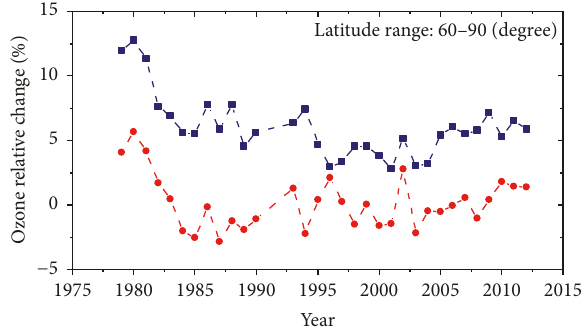
Figure 1: The annual-mean ozone thickness anomalies relative to 40 DU (Dobson Unit) above 10hPa over latitude range from 60 ∘ to 90 ∘ from 1979 to 2012. We averaged ozone data in this latitude range with considering the latitude weight. The blue squares and red spots connected with dash lines denote the data points of the NH and the SH, respectively.